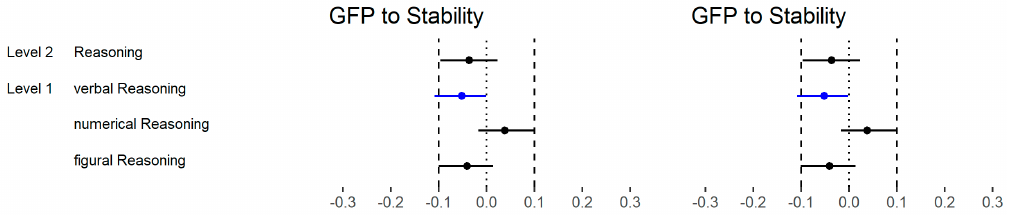
Figure 7. Study 1: Evaluation of the Brunswik Symmetry principle with regard to personality. Change of correlations when Stability and Plasticity (Big Two) were considered instead of GFP (both high level). Blue lines indicate substantially different correlations based on an equivalence testing approach.